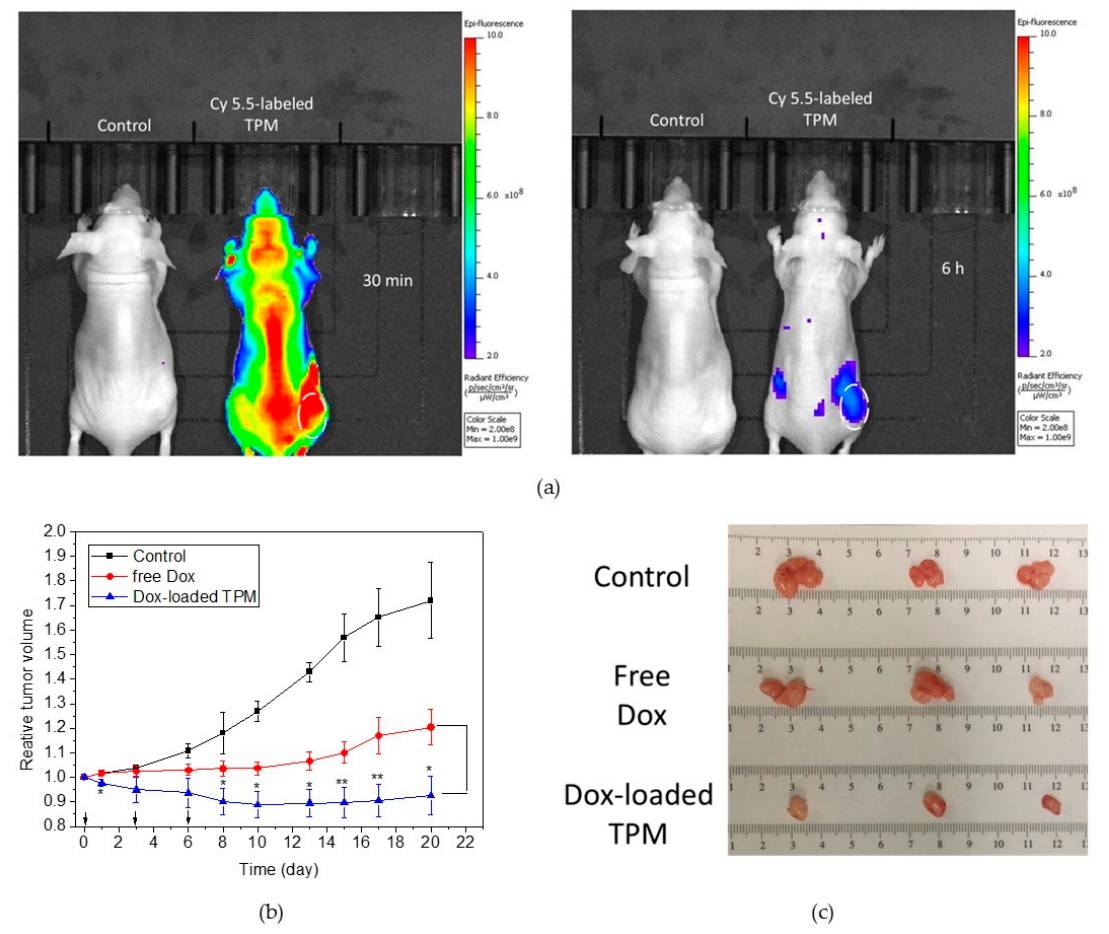
Figure 5. In vivo evaluation of the secondary structure contained mixed micelles. ( a ) The optical florescence of human lung cancer A549 bearing nude mice at post 30 min and 6 h injection with Cy5.5-labeled TPM micelles. The fluorescent intensity of the tumor marked. ( b ) Antitumor efficacy in A549 cells-inoculating nude mice. The tumor-bearing nude mice were divided into 3 groups and independently intravenously administered with PBS, doxorubicin and Dox-loaded mixed micelles at a 10 mg/kg/mL of Dox equivalent dosage each time. Total three dosages were given, present in arrows. The tumor sizes were monitored and the comparison with each group was statically analysis. The asterisk markers represented the statically significant differences (* p < 0.05 and ** p < 0.01). ( c ) After 20 d treatment, the mice were sacrifice and the tumor tissues were collected and photographed.